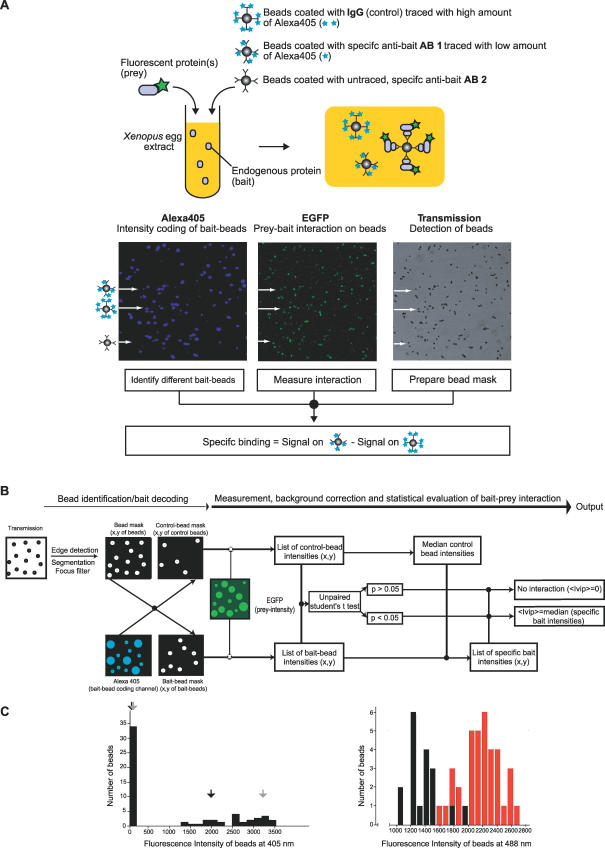
The VIP Assay(A) Scheme of VIP methodology. AB1/AB2: specific antibodies recognizing endogenous bait.(B) Flow diagram of the automated image processing used for VIP.(C) Histograms of Alexa405 fluorescence (left panel) and EGFP fluorescence (right panel) on beads in an in vitro VIP experiment in which 1,600 nM EB1-EGFP was titrated into CSFXB buffer containing 300 nM XMAP215, anti-XMAP215 beads, and Alexa405-IgG beads. Different bead species (IgG/bait beads) are encoded by distinct Alexa405 emission (left panel). Each bead species is defined by the S.D. of Gaussian distributions (the black arrow marks the beginning and the grey arrow the end of the confidence interval) fitted to the Alexa405 histogram. Beads with Alexa405 intensities lying within the S.D. of the low-intensity population are defined as IgG beads. Beads with Alexa405 intensities lying within the S.D. of the high-intensity population are defined as bait beads (here: anti-XMAP215 beads). The emission of the two species (black: IgG beads; and red: anti-XMAP215 beads) in the EGFP channel is represented as a histogram (right panel). The VIP signal is calculated by subtracting the median intensity of bait beads in the EGFP channel by the median intensity of IgG beads in the EGFP channel only if there is a significant difference (p < 0.05, unpaired t-test) between these two populations.